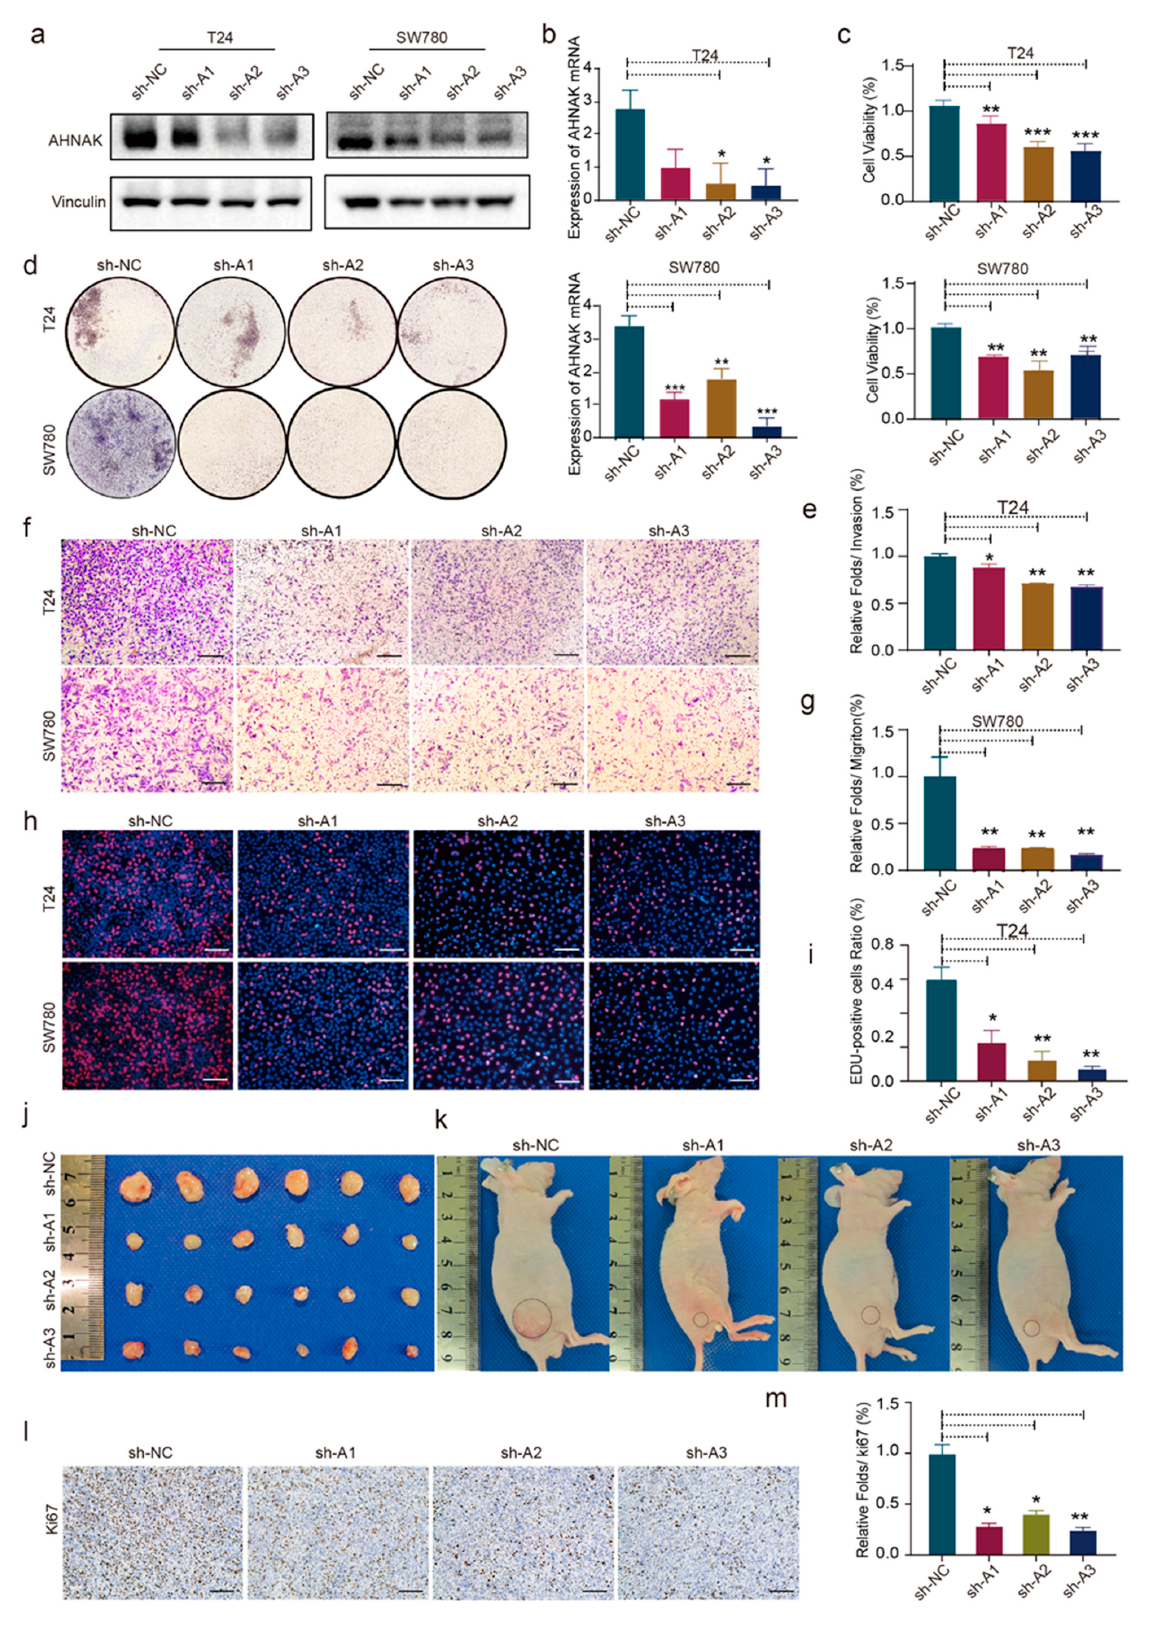
Figure 6. AHNAK accelerates BC cell proliferation, migration, and invasion in vitro and in vivo. ( a , b ) Western blotting and PCR results of the AHNAK-knockdown T24/SW780 cells. ( c ) Cell